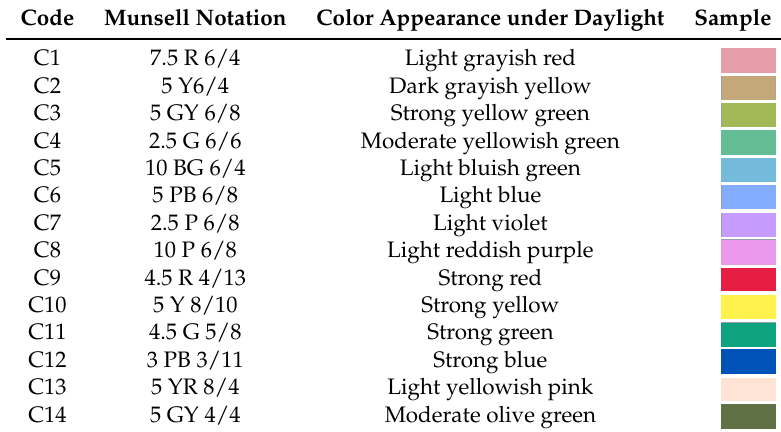
Table 1. List of Commission Internationale de l’Eclairage (CIE) Test Color